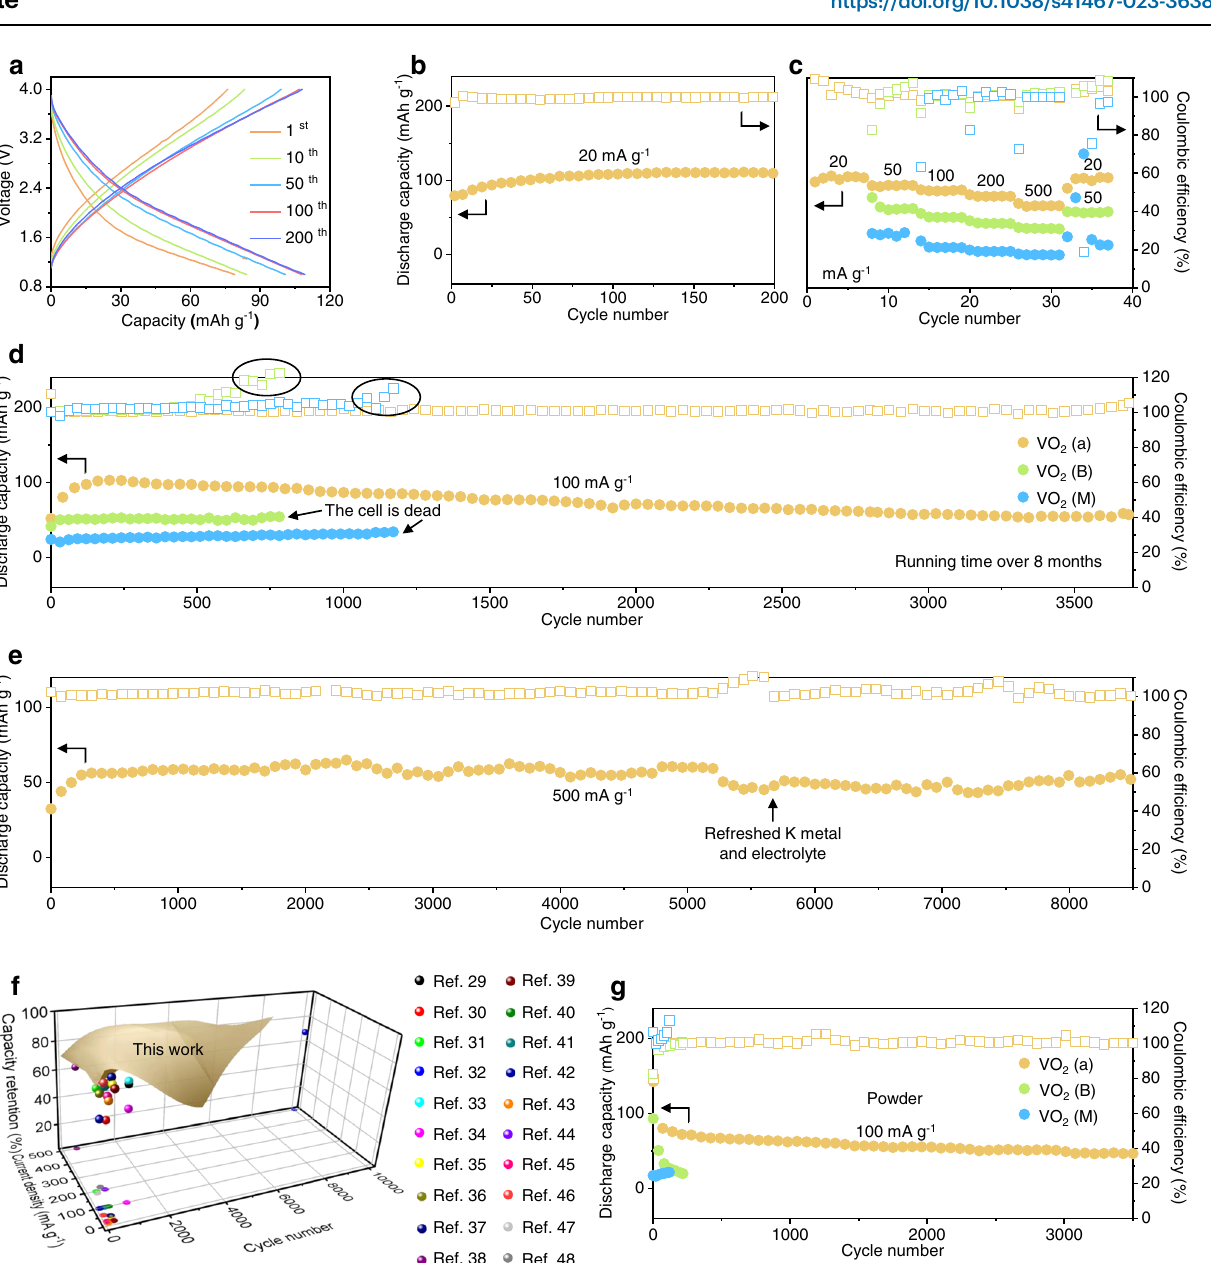
500mAg − 1 . f ComparisonofcyclingpropertiesofVO 2 (a)withdifferenttypesofPIB cathodes. g Cycling performance of the powders of amorphous VO 2 , B phase VO 2 , and M phase VO 2 at 100mAg − 1 .